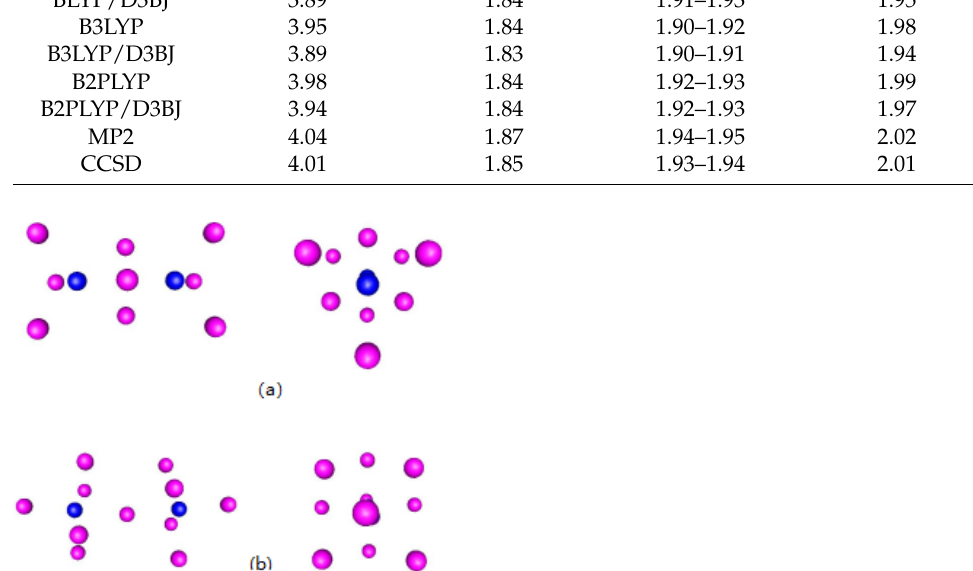
Figure 3. Li 9 N 2 ( a ) and Li 11 N 2 ( b ) structures from different perspectives, as observed in the CPMD simulations and then optimized in vacuo (BLYP). Upper row: Li 9 N 2 (D3h), lower row: Li 11 N 2 (D4d). Nitrogen: magenta, lithium: blue. The D3h symmetry of Li 9 N 2 and the close-to D4d symmetry of Li 11 N 2 were not imposed in the input but were obtained from the